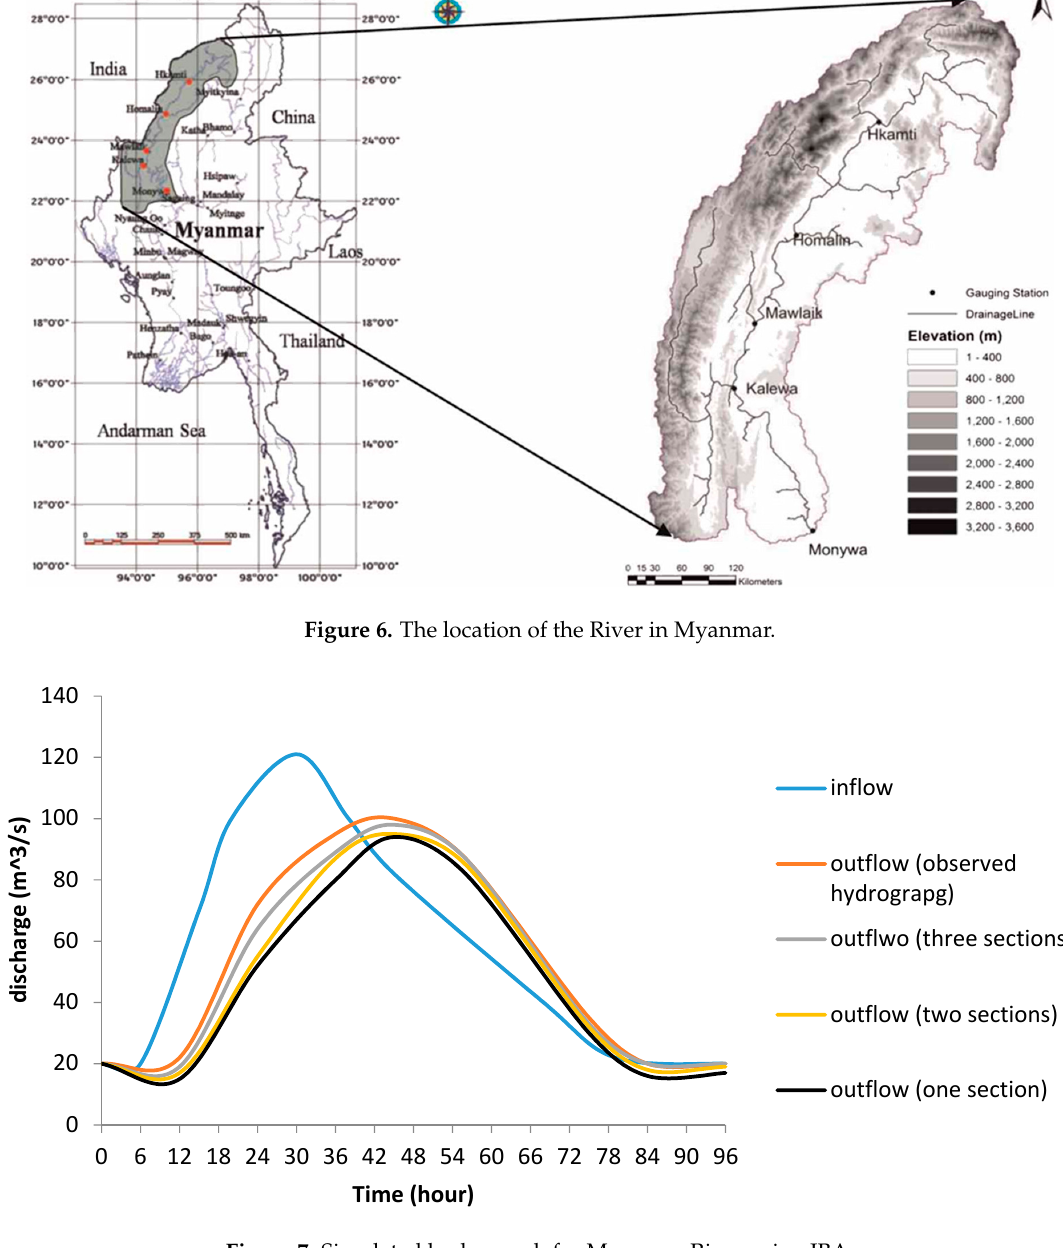
Figure 8. Advanced Muskingum model for flood plain with complex boundary condition. 4. Conclusions The present study investigated the potential of utilizing a three-parameter Muskingum model coupled with Improved Bat Algorithm (IBA) to accurately predict flood routing. Three different case studies have been used in this study, to evaluate the performance of the proposed model. These three case studies were the Wilson flood, Karahan flood, and Myanmar River. Seven different performance indices were used to examine and compare the performance of the proposed model over other algorithms. In addition, discretization of the river stream was considered to improve model accuracy. The results showed that IBA outperformed all other algorithms and was able to reduce the SSD by percentages ranging between 20% and 84%, compared with the other algorithms. In addition, the achieved results using the IBA could predict the peak discharge accurately, with a value very close to the observed one. Under the Karahan flood, IBA considerably achieved the minimum level of error indices for a single reach, compared to other algorithms. Finally, IBA in flood routing with three intervals had a better performance than with single and two reaches. The division of the river into different reaches increased the accuracy of flood routing. The performance of IBA for the river in Myanmar, also showed that the simulated hydrograph with three reaches was more accurate. For